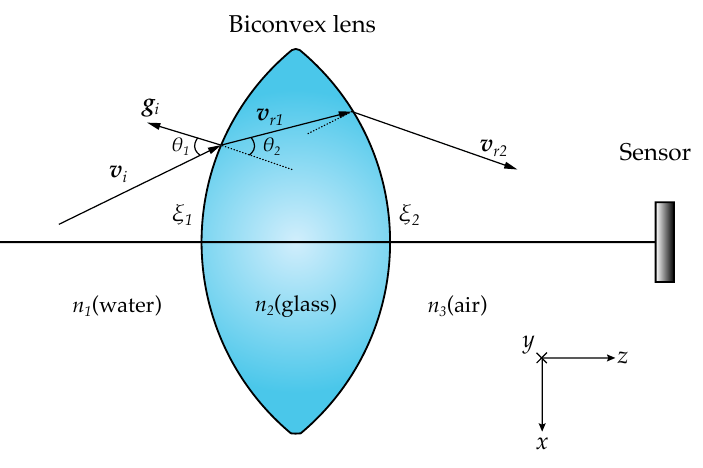
Figure 7. Photon as ray vector being refracted at both medium interfaces. The lens directs the photons to the sensor.